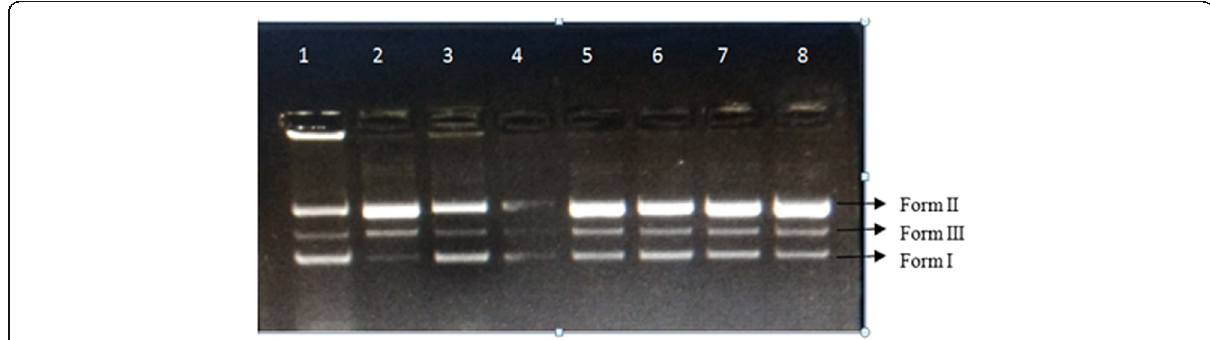
Fig. 3 DNA Nicking assay revealing protective potential of TES17 extract against free radicals generated by Fenton ’ s reagent. Lane 1: Negative control (only DNA); Lane 2: Fenton ’ s reagent; Lane 3: Positive control (rutin, 10 μ g); Lane 4 – 8: Fenton ’ s reagent + 2, 4, 6, 8 and 10 μ g of TES17 extract; Form I = Supercoiled; Form II = Linear; Form III = Single strand nicked